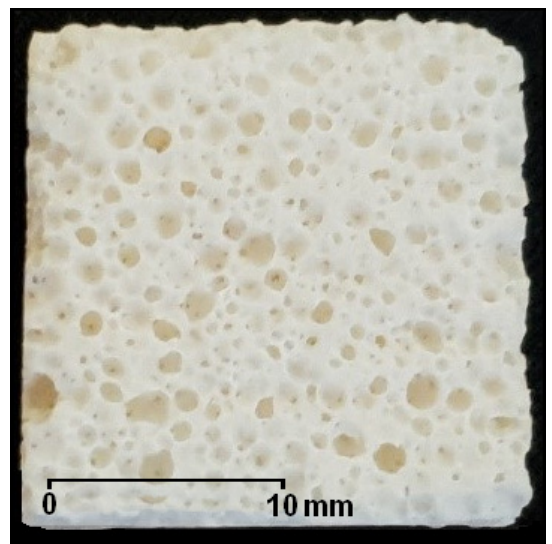
Figure 1. Sample of a porous corundum biomaterial. The final formation of the material was approved by FT-IR ATR spectroscopy (Figure 2). Additionally, the analysis revealed residues from the synthesis process in the form of